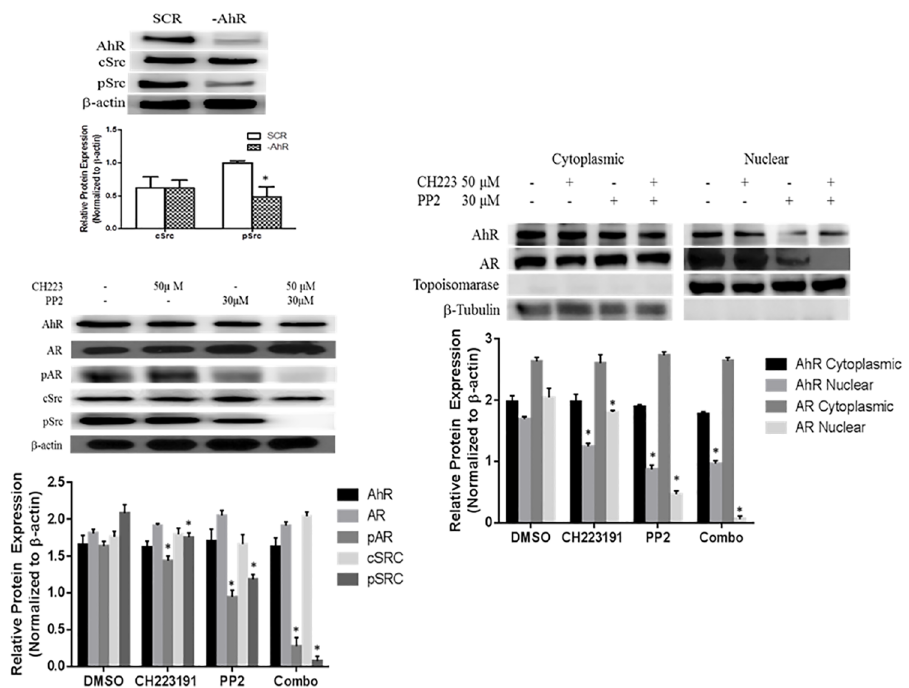
Fig 1. AhR and Src inhibition synergistically reduces pAR expression and nuclear localization. (A) C4-2 cells were transfected with a vector carryinga shRNA for AhR (-AhR) or a scrambledcontrol vector (SCR). Total cellularproteins were isolatedfrom 75% confluent cell cultures and separated by SDS polyacrylamine gel electrophoresis and blotted using anti-AhR antibody,anti-cSrc antibody, anti-pSrc antibody. Anti- β -actinwas used as a loadingcontrol. ParentalC4-2 prostate cancer cells were also treated with AhR inhibitor (CH223191) and Src kinase inhibitor(PP2) alone and in combination. DMSO served as a vehiclecontrol. (B) Total cellularproteinswere isolatedand proteins were separatedby SDS polyacrylamine gel electrophoresis and blotted using anti-AhRantibody, anti-AR antibody,anti-pAR antibody,anti-cSrc antibody, anti-pSrc antibody.Anti- β -actinwas used as a loadingcontrol. Figure is representative of 3 independent membranes. (C) Nuclearand cytoplasmic fractionation: C4-2 cells grown on 100 mm dishes until * 75% confluentwere treated with DMSO, CH223191and PP2 as describedabove. Cells were washedwith cold PBS and cellularfractions were isolated per manufactures instructions using a NE-PER Extraction kit. The nuclear and cytoplasmic fractions were analyzedby western blotting for AhR and AR protein expression. The relative level of cytoplasmic AhR & AR were normalizedwith β -tubulinexpressionand the relative level of nuclear AhR AR were normalized with topoisomerase expression. Blots are representative of three independent